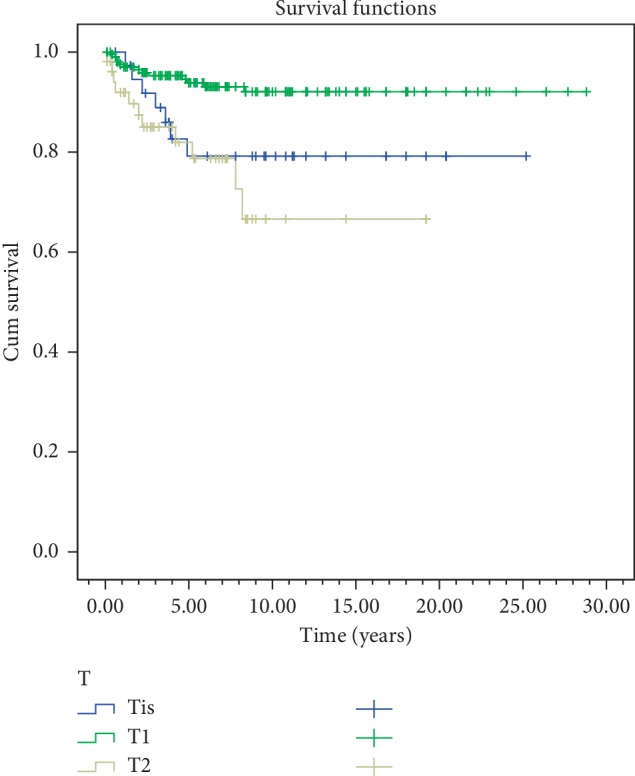
Local control by T classifications.